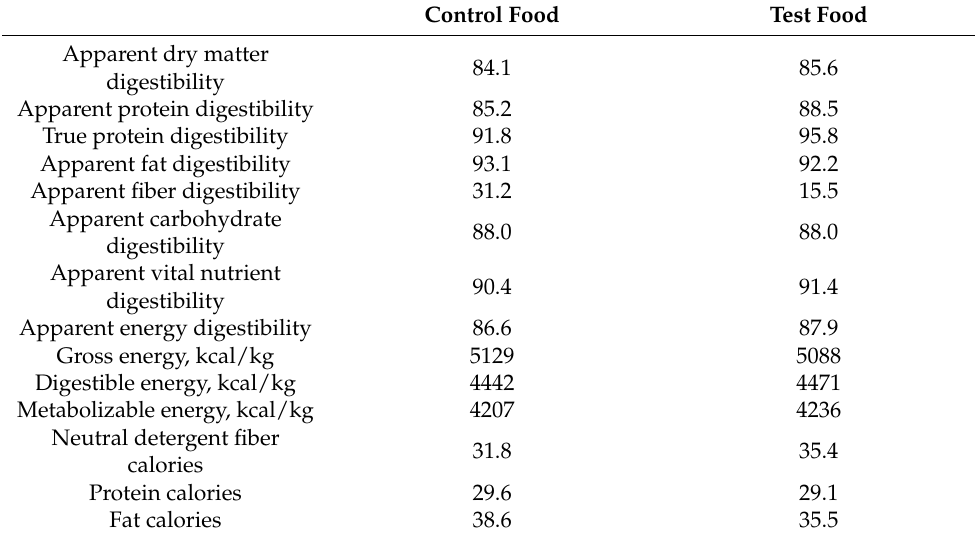
Table 2. Digestibility analyses.